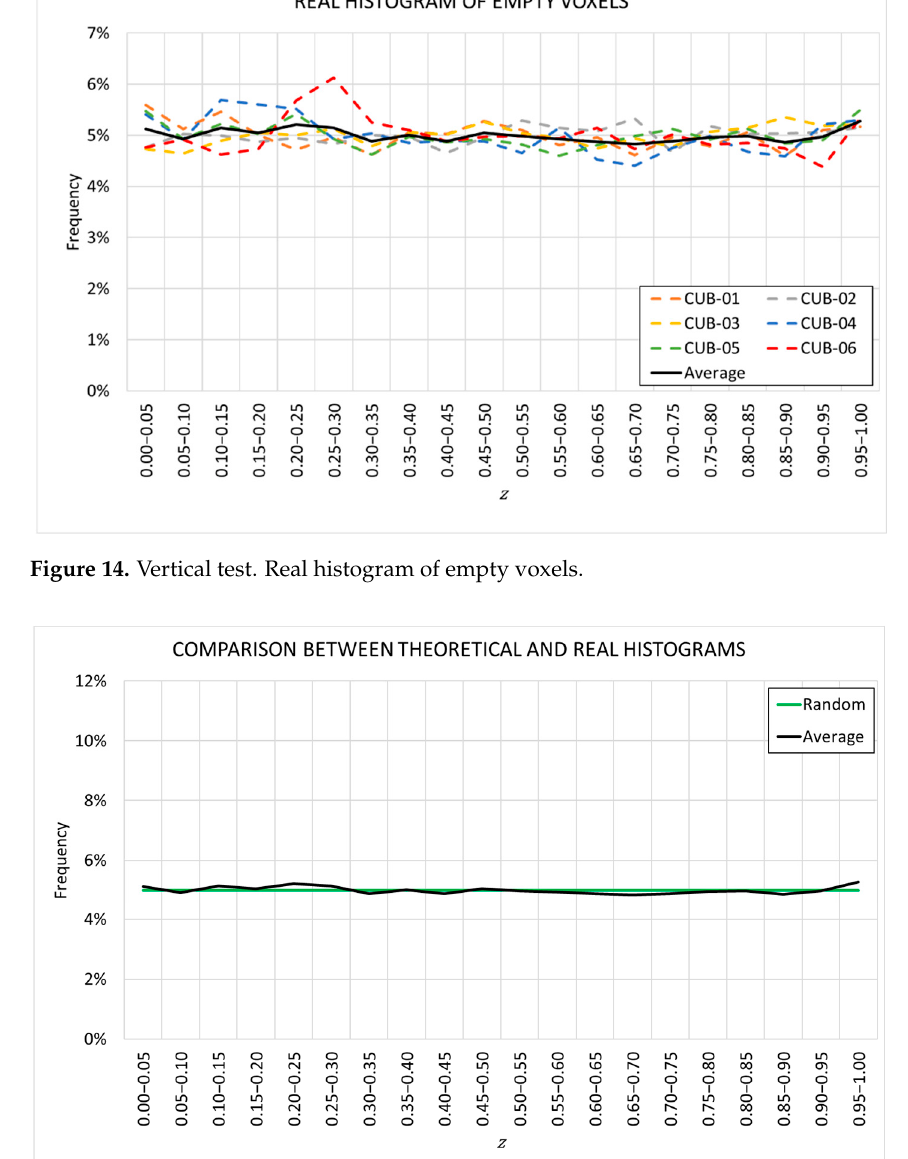
Figure 13. Vertical test. Theoretical histogram of empty voxels according to a random distribution.